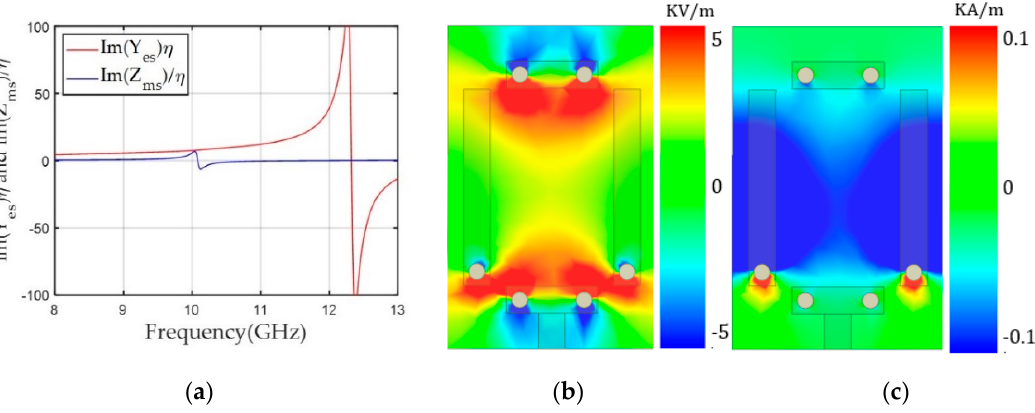
Figure 3. ( a ) Y es and Z ms values of the unit cell according to frequency for a transmission phase of − 150 ◦ . ( b ) The y component of the electric field (E y ). ( c ) The x component of the magnetic field (H x ) along the x-y plane in the middle of the unit cell at 10 GHz.